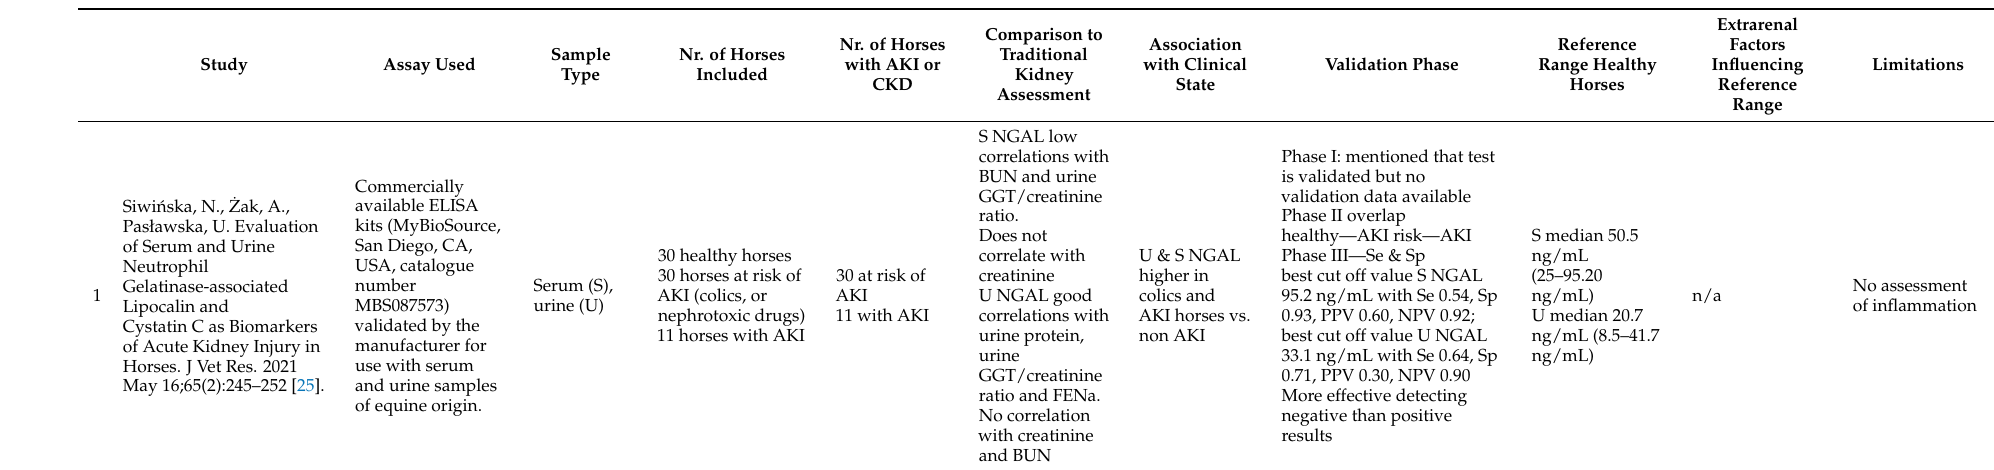
Table 5. List of studies on neutrophil gelatinase-associated lipocalin (NGAL) in horses and its analytical and clinical